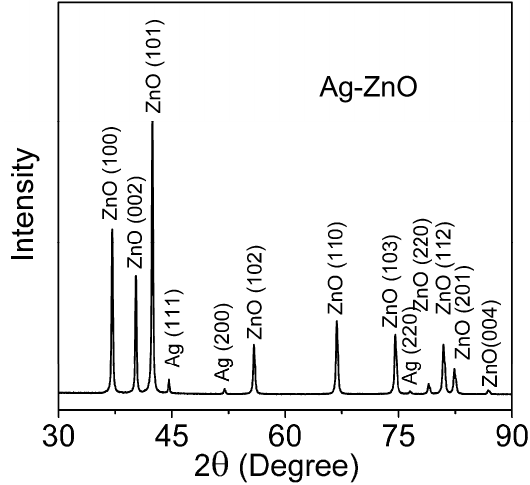
Figure 1. XRD pattern for the prepared Ag-ZnO hierarchical microparticles obtained by the synthetic method.